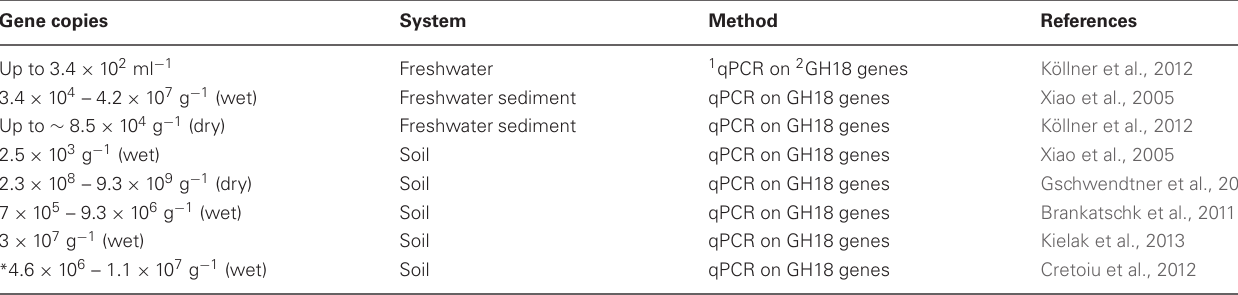
Table 5 | Chitinase gene copies numbers in natural